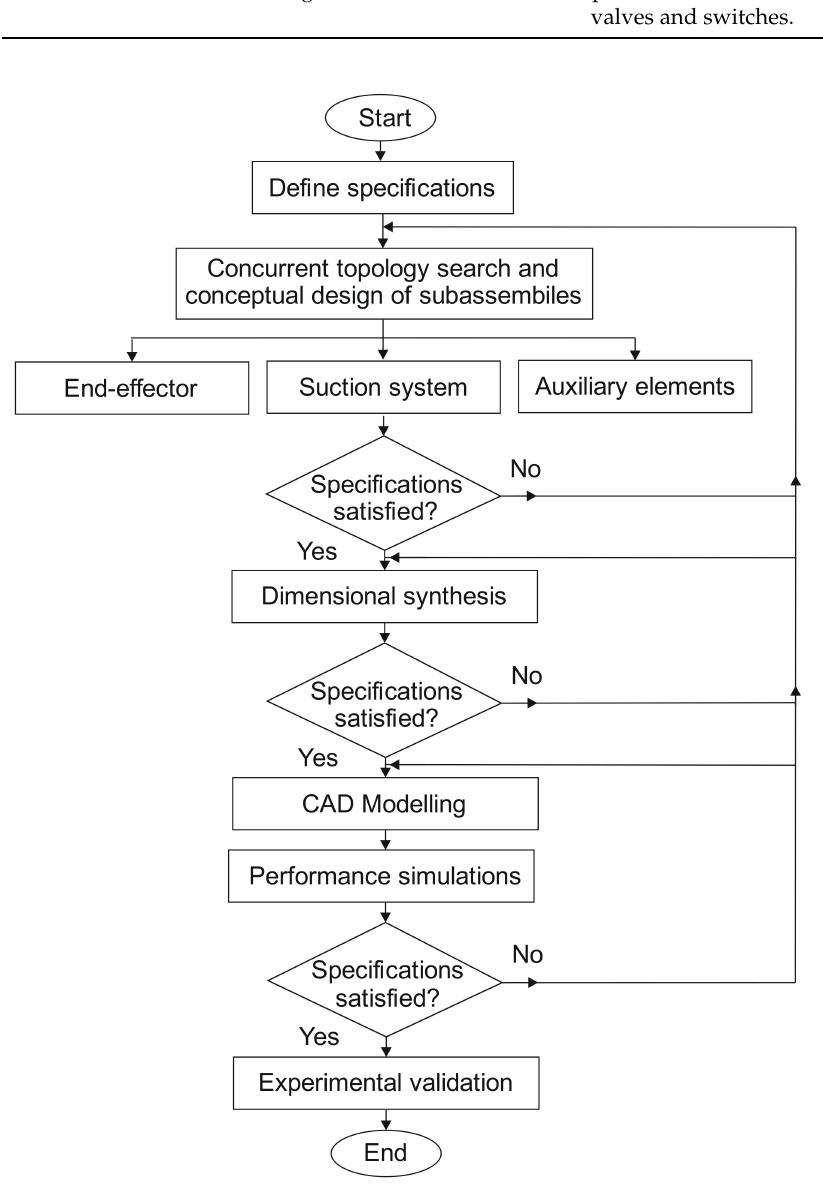
Figure 1. Design phases